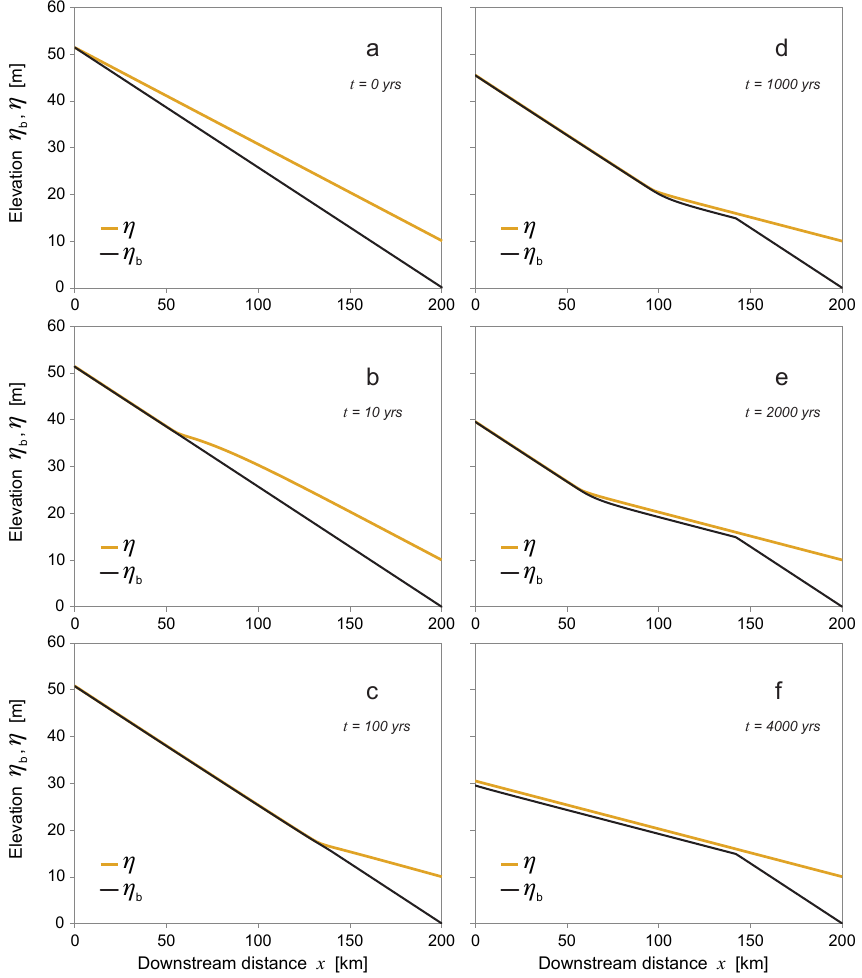
Figure 16. MRSAA model evolution of bed top and bedrock profiles with an imposed alluvial river mouth at the downstream end and an upstream-migrating bedrock–alluvial transition. The results are for (a) t = 0 years, (b) t = 10 years, (c) t = 100 years, (d) t = 1000 years, (e) t = 2000 years and (f) t = 4000 years (steady state). Here (a) , (b) and (c) show the early response, and (d) , (e) and (f) show the late response. In these plots, η denotes elevation of the bed surface, η b denotes elevation of the bottom of bedrock relief, and x denotes streamwise distance. Compare with the CSA model solution in Fig.